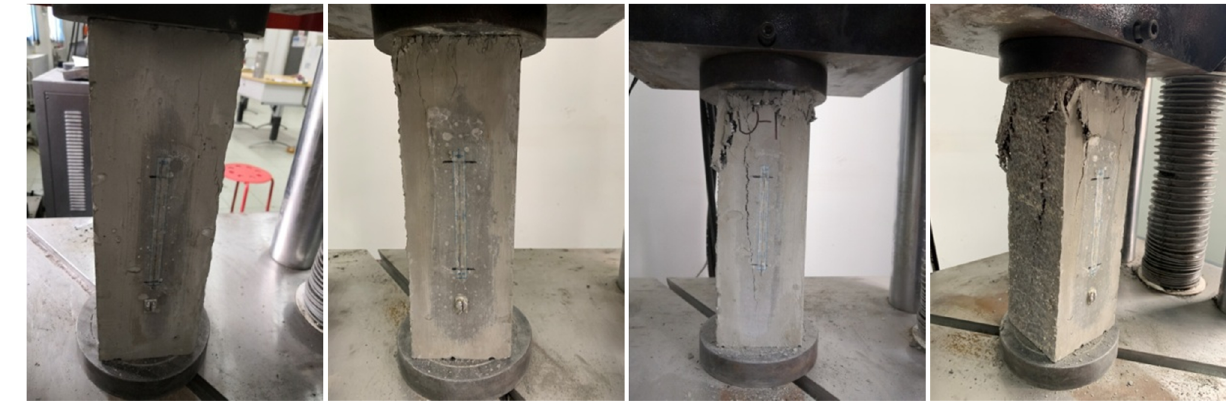
Figure 7: Failure mode of group U